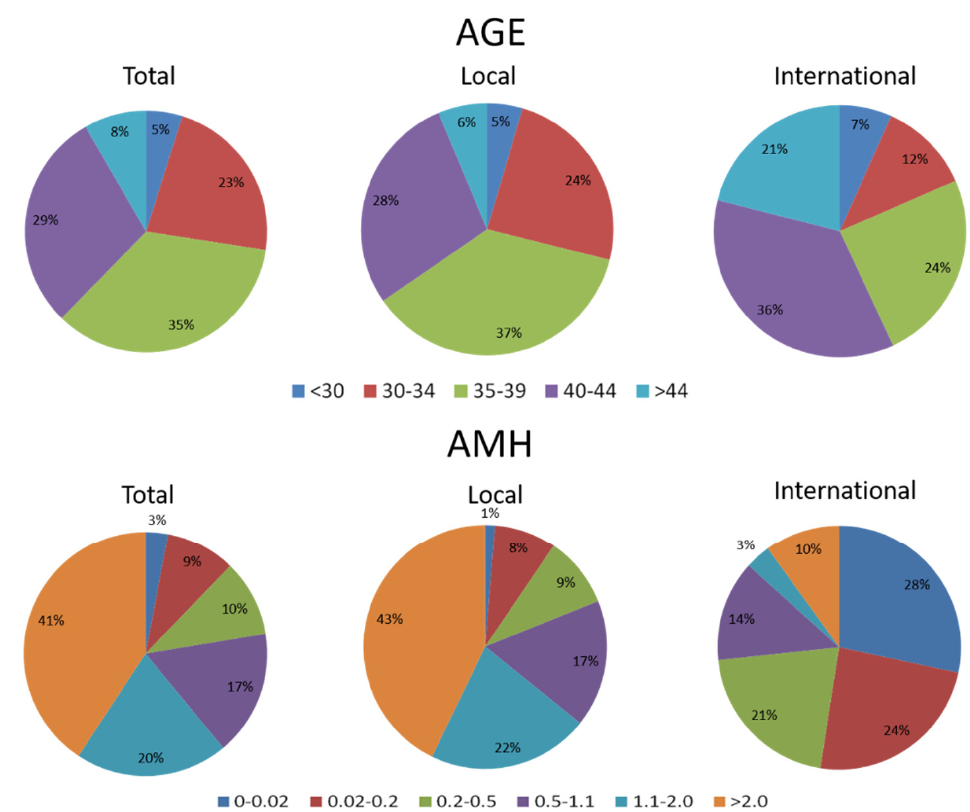
Figure 1. The distribution of age and anti-Mullerian hormone (AMH) levels among women who received assisted reproduction in our unit between 2015 and 2019. The percentage of advanced maternal age ( ≥ 35 years old) was 71% and 81% in local and international patients, respectively. The percentage of them with poor ovarian reserve is 87% in international patients (including 21% diminished ovarian reserve, and 52% impending ovarian failure with AMH ≤ 0.2). Local: Taiwanese patients, International: mostly Mainland China